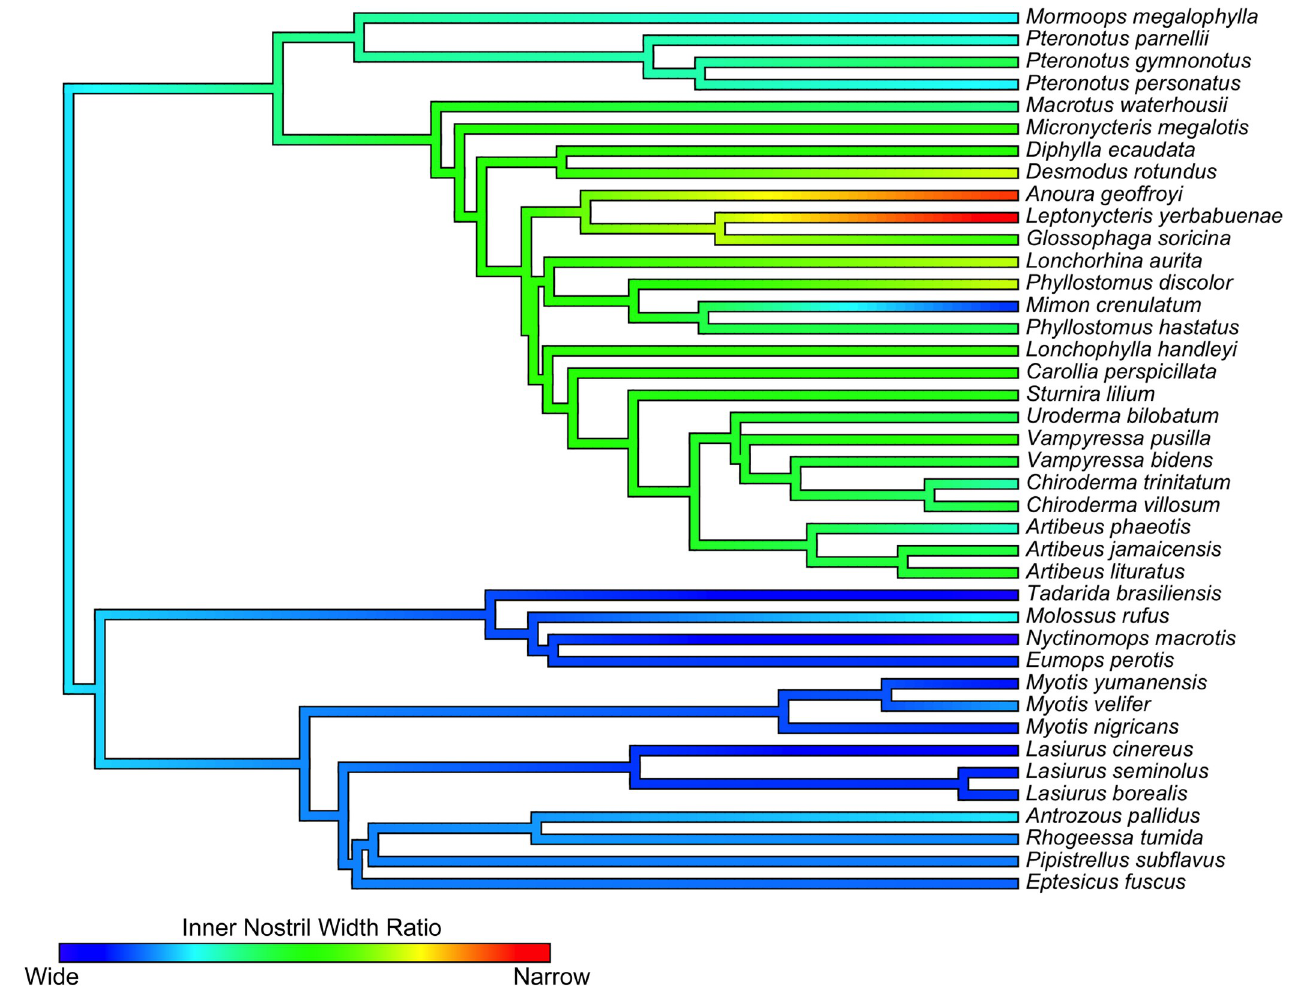
Fig 4. Ancestral character estimation of inner nostril width ratio (INWR). Red colors indicate species with narrow nostrils relative to head width, while dark blue indicates species with relatively wide nostrils. Illustration made in R ( contMap function, package phytools; [47]).